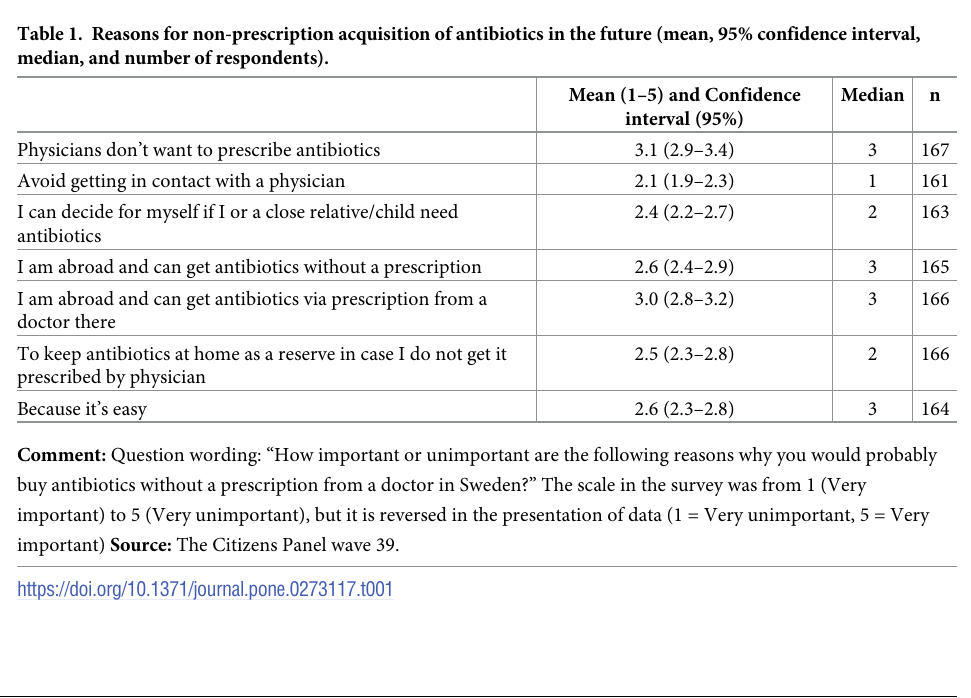
Table 1. Reasons for non-prescription acquisition of antibiotics in the future (mean, 95% confidence interval, median, and number of respondents).